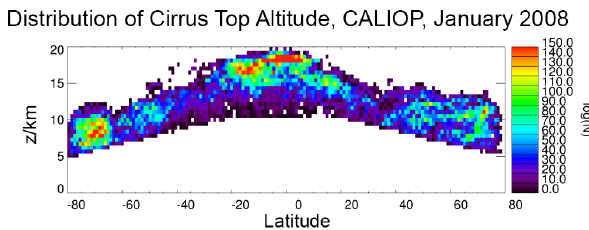
Figure 3. Cirrus top altitude distribution after applying the filter criteria described in Sect. 3.2 for January